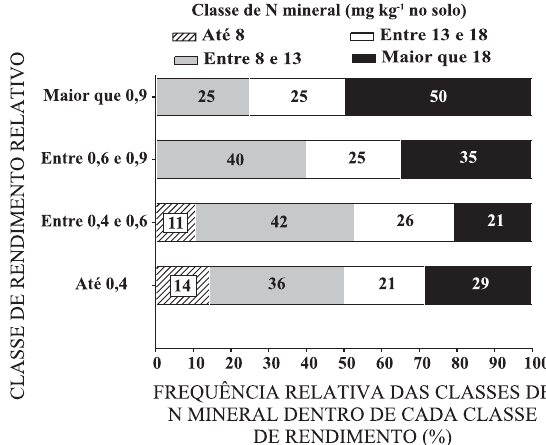
Figura 6. Frequência relativa das classes de rendimento relativo em cada classe de N